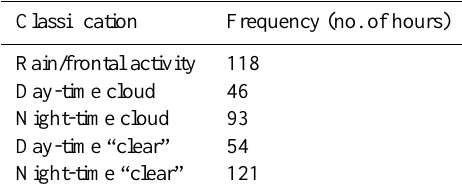
Figure 2. Meteorological data measured using Vaisala WXT510 weather station at BT Tower during REPARTEE II. a) Mean wind-speed and direction frequency data per 45 sector